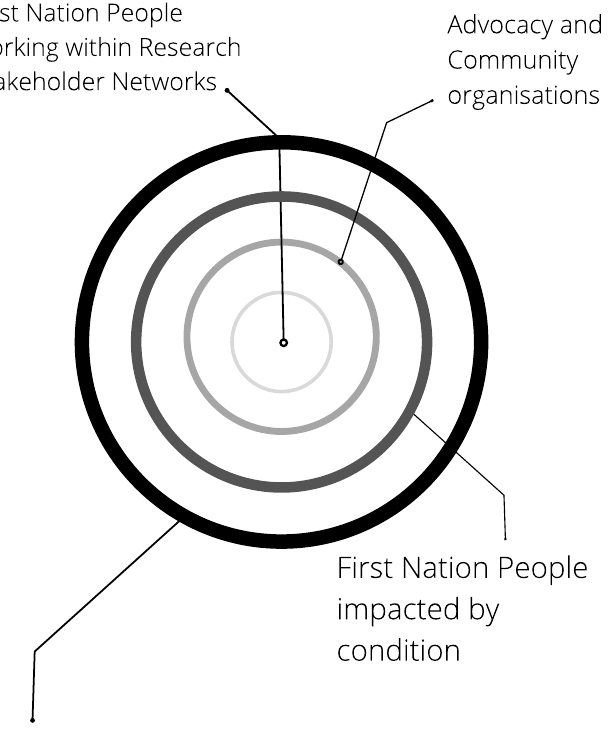
Figure 1. Contextual definition of community: purposeful processes of engagement, feedback and learning within a complex, dynamic and everchanging ecosystem.